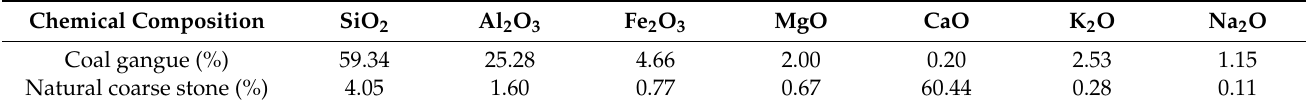
Figure 4. Appearance and microstructure of coal gangue ( a ) Macrostructure ( b ) Microstructure. Table 2. Chemical composition of coal gangue and natural coarse stone.